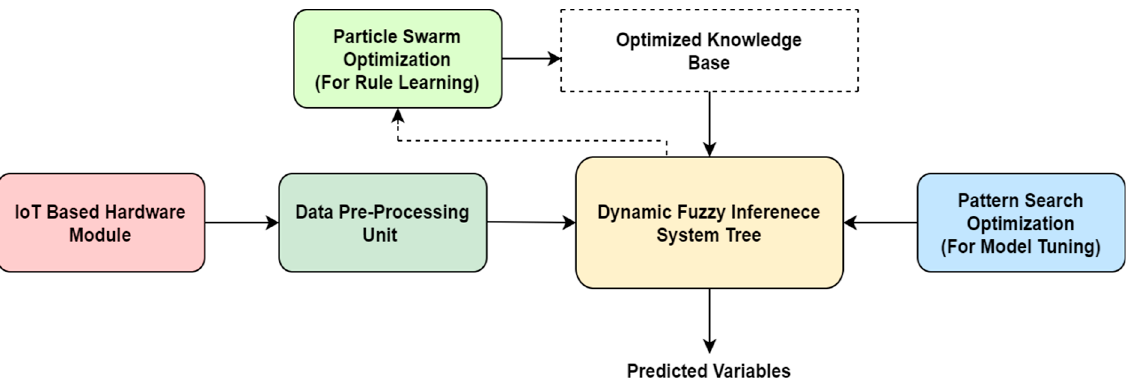
Figure 7. Full system architecture for proposed ADFIST IAQ parameter prediction approach.